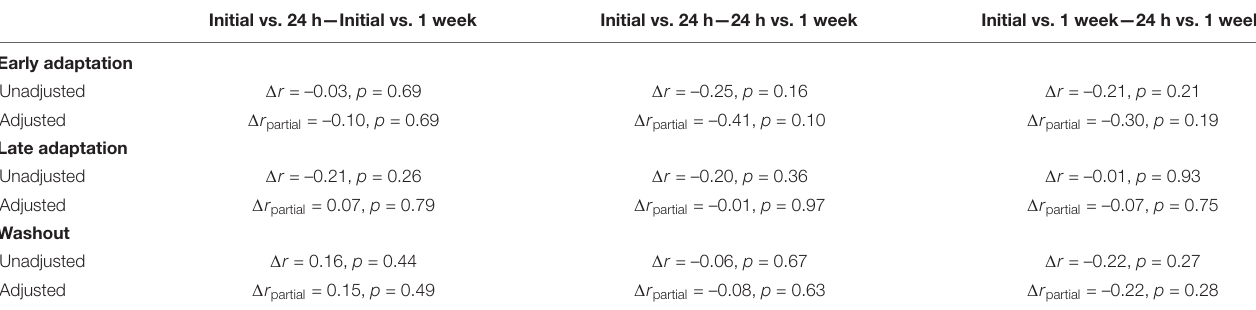
TABLE 1 | Differences in the strength of correlations between peak lateral deviations measured across testing sessions. Initial vs. 24 h—Initial vs. 1